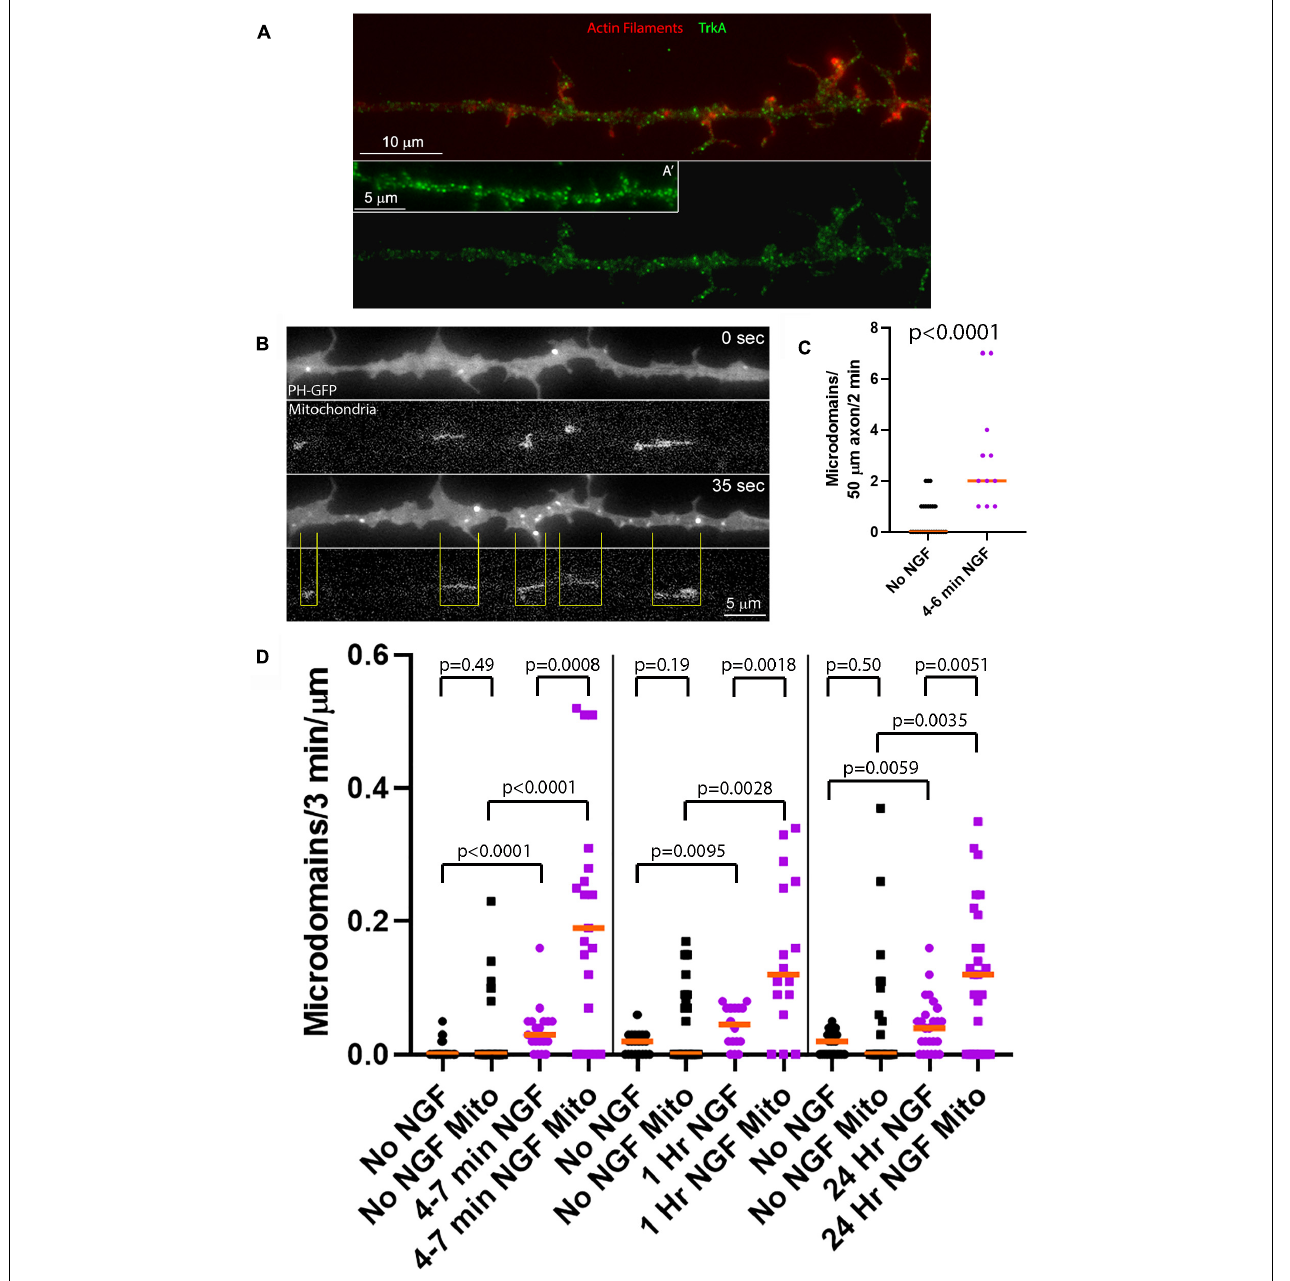
FIGURE 1 | NGF preferentially increases the rate of formation of PIP3 microdomains in axon segments populated by mitochondria. (A) Examples of the distribution of the TrkA receptor in the membranes of sensory axons as determined by immunostaining with an antibody to the extracellular domain of TrkA under non-permeabilized conditions as in Gallo et al. (1997) and Ketschek and Gallo (2010). (A (cid:48) ) shows an example of an additional axon. Actin filaments were visualized using phalloidin. (B) Example of an NGF treated axon (4–7 min) expressing PH-GFP and with mitochondria labeled using mitochondrially targeted DsRed. At 0 s, representative of 4 min after NGF treatment, a few microdomains are visible as reflected by localized accumulation of PH-GFP. At 35 s a burst of microdomain formation has occurred. The yellow lines denote the positioning of mitochondria relative to the microdomains and define axon segments populated by mitochondria. Note that the majority of microdomains are formed in axon segments populated by mitochondria. (C) Quantification of the rate of microdomain formation per unit length/unit time of axon at 4–6 min after NGF treatment. Mann-Whitney test. (D) Analysis of the rate of microdomain formation in axon segments populated by mitochondria (Mito) and those lacking mitochondria as a function of time after NGF treatment. For each time point after NGF treatment (4–7 min, 1 and 24 h) time matched no NGF treatment control groups are shown. The rate of microdomain formation is normalized to the unit length of micron as mitochondria differ in length and the segments not populated by mitochondria similarly vary in length. The top row of p -values (shorter brackets) report on within NGF treatment group comparing axon segments populated by mitochondria to those that did not. The rest of the p -values report on comparisons within axon segments populated by mitochondria or not and between NGF treatment conditions. Mann-Whitney tests